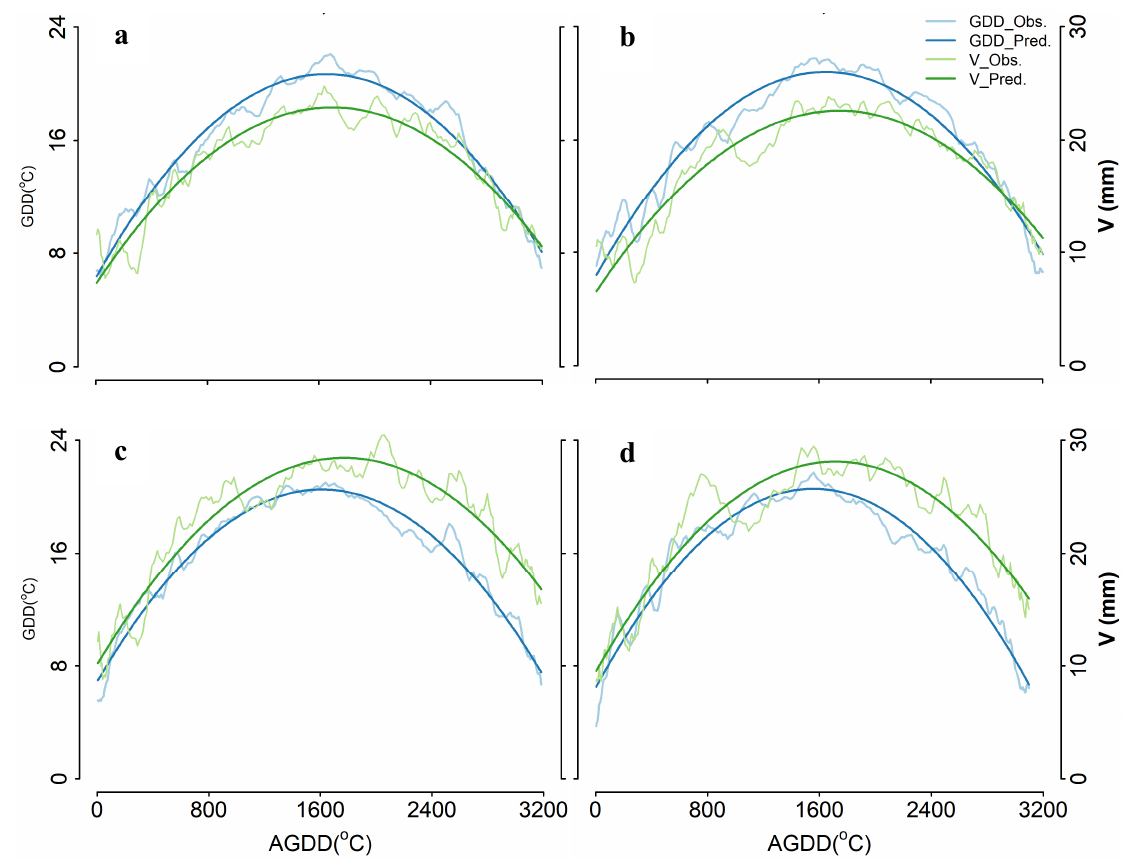
Figure 8. Convex quadratic models for GDD and V for site 1 (a,b) and 13 (c,d) in ND for temporal group averages 2003–2005 plus 2007 (a,c) and 2013–2016 (b,d). GDD and V were fitted for DOY 91 – 330.